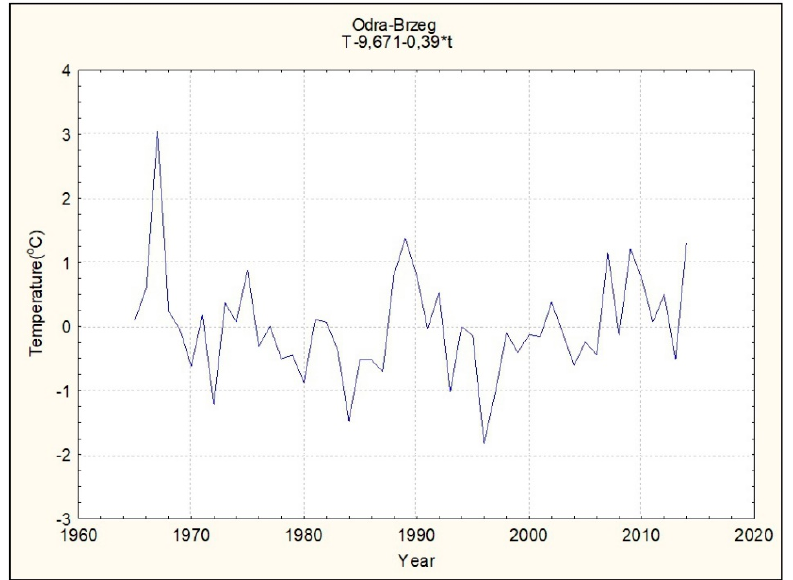
Figure 7. Average annual water temperature with the excluded trend (for Oder-Brzeg trend is T = 0.39 × t + 9.671).